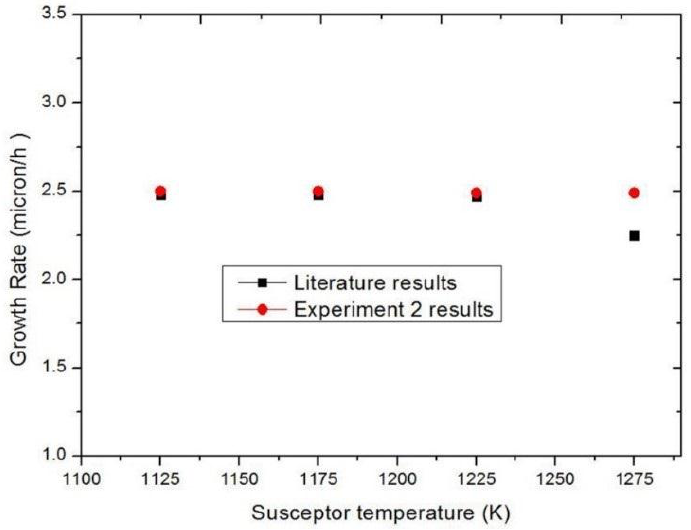
Figure 18. 2D Experiment 2 results vs. literature results [11].